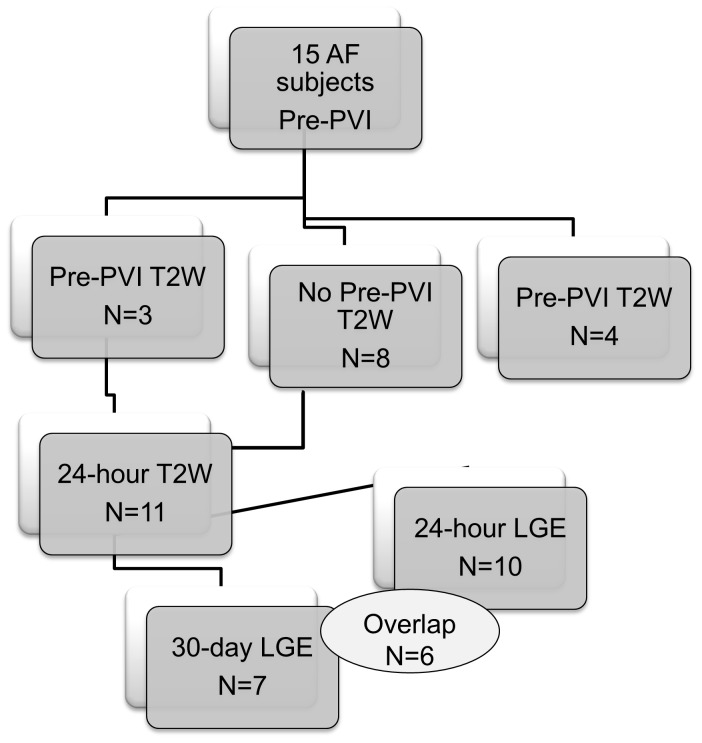
Flow chart describing the number of patients with T2W and LGE images at each time-point for the entire cohort.T2W = T2-weighted imaging. LGE = Late gadolinium enhancement. PVI = pulmonary vein isolation. Data from all available studies were used in all analyses.